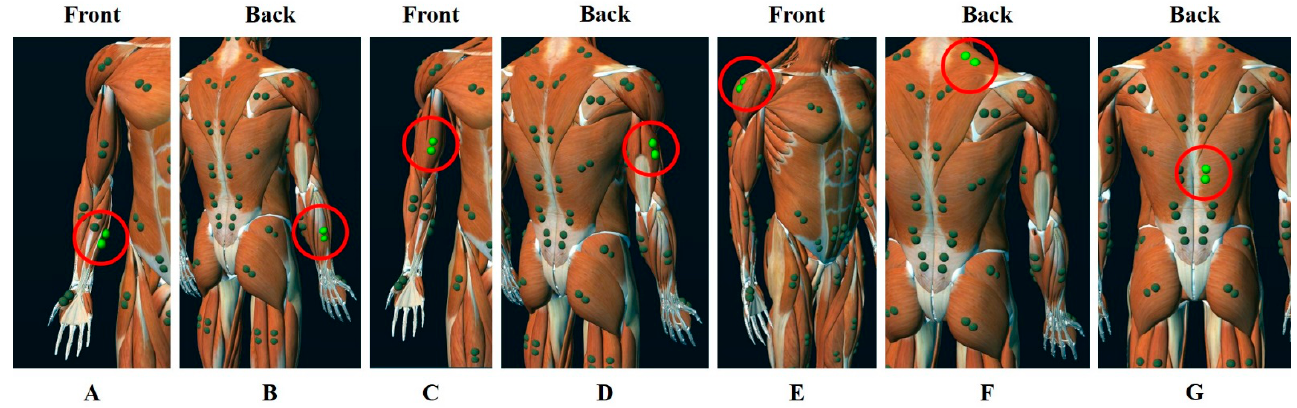
Figure 3. Location of electrodes (source: Noraxon MR3 3.12.42 software program, Noraxon Inc., Scottsdale, AZ, USA); ( A ) = Flexor Carpi Ulnaris, ( B ) = Extensor Carpi Radialis, ( C ) = Biceps Brachii, ( D ) = Lateral Triceps, ( E ) = Middle Deltoid, ( F ) = Upper Trapezius, ( G ) = Erector